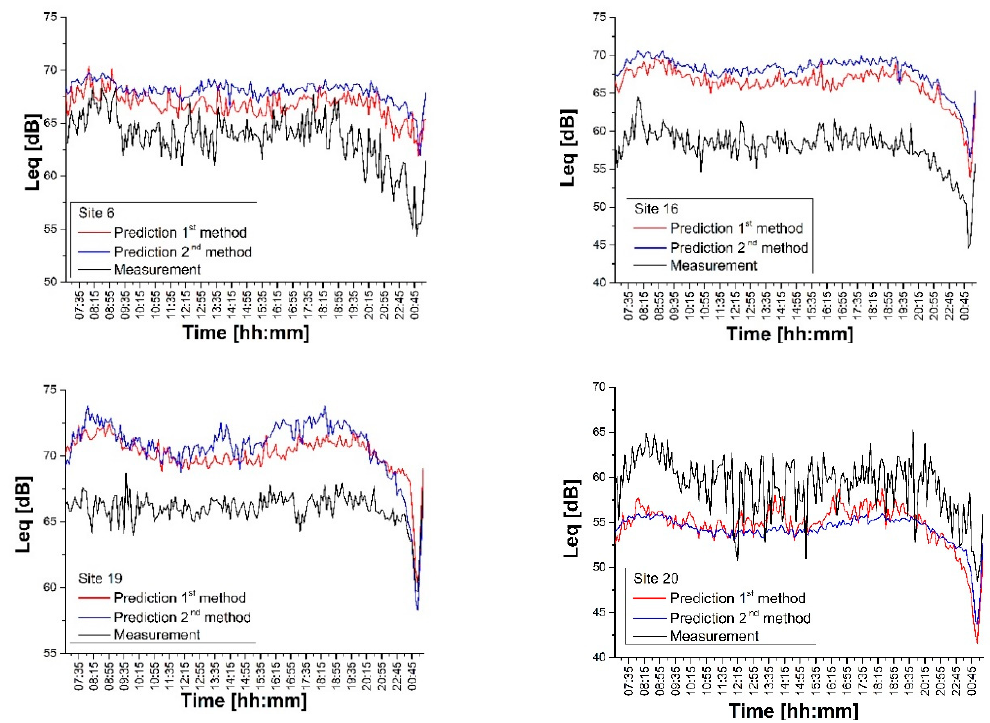
Figure 13. Comparison between traffic noise measurements at Sites 6, 16, 19, 20 and the corresponding DYNAMAP predictions according to two calculation methods (cfr. Equation (8) or Equation (10)).